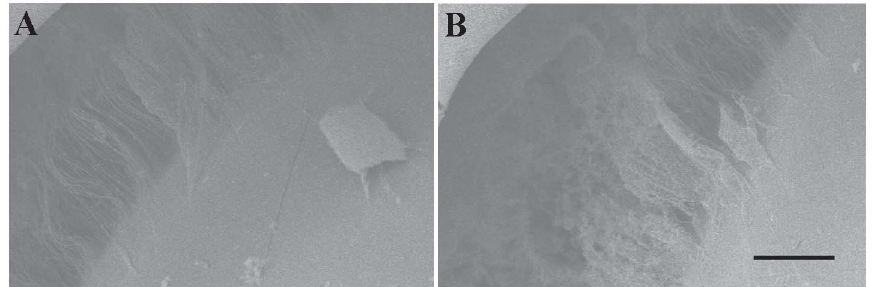
Figure 5. Zonular fiber disruption after plasmin treatment. Zonular fiber disruption after intravitreal injections of plasmin in scanning electron microscopy (SEM). The SEM findings showed that the zonular fibers remained intact in the control eyes (A), however zonular fiber disruption was noted in the eyes treated with plasmin (B). Scale: 400 m m.